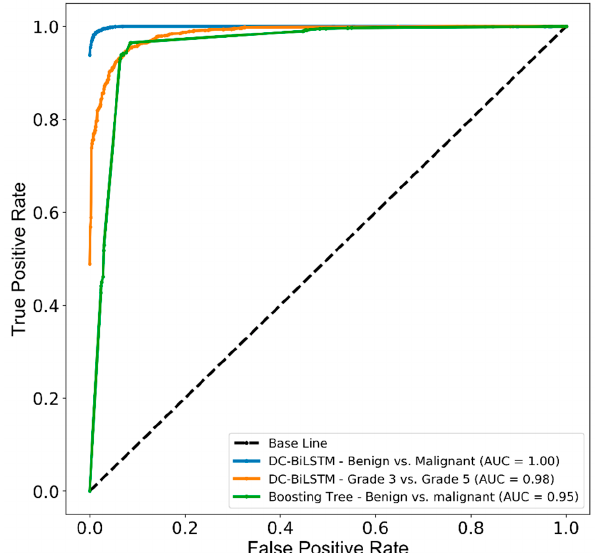
Figure 8. The receiver operating characteristic (ROC) and area under the curve (AUC) for PCa classification between benign and malignant tissues, and within malignant tissue samples. The test performance of DC-BiLSTM and Boosting tree classifiers used the internal and external test da- tasets.